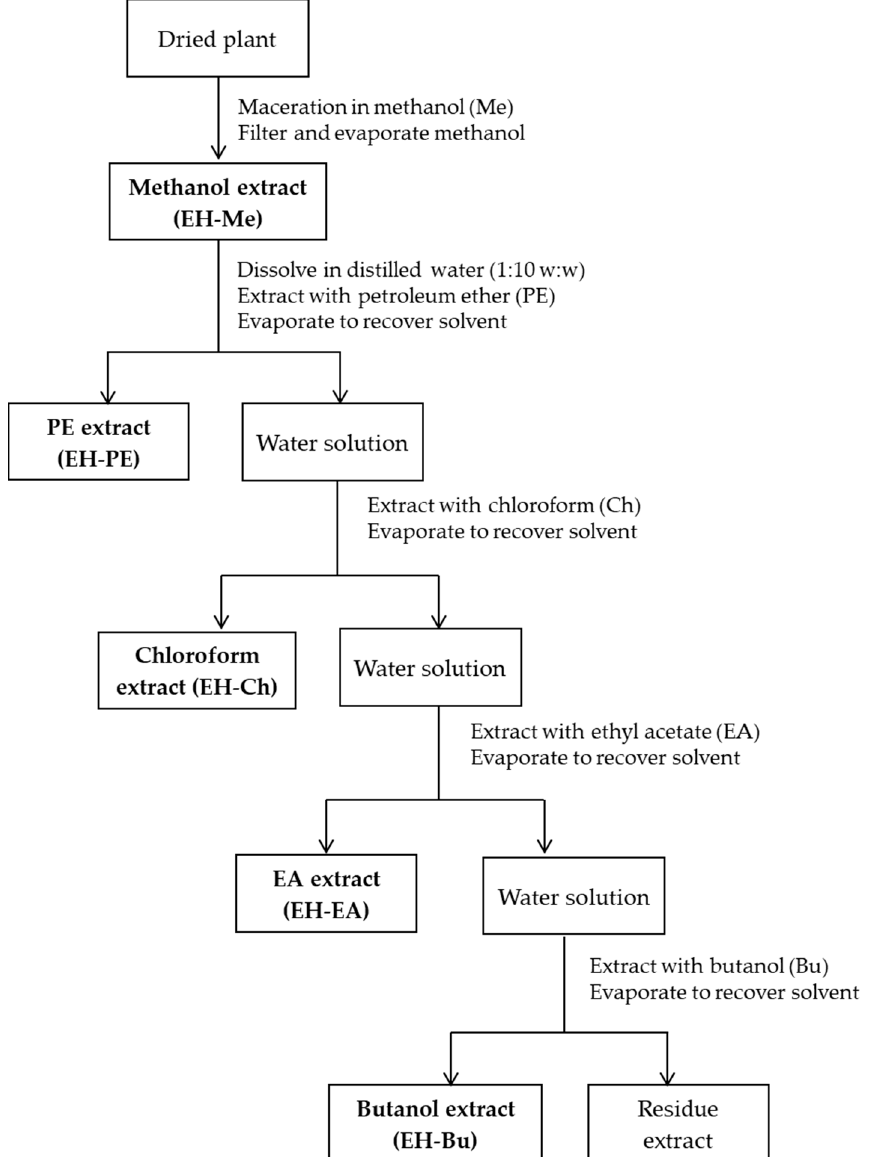
Figure 2. The chart indicates the process of solvent extraction.